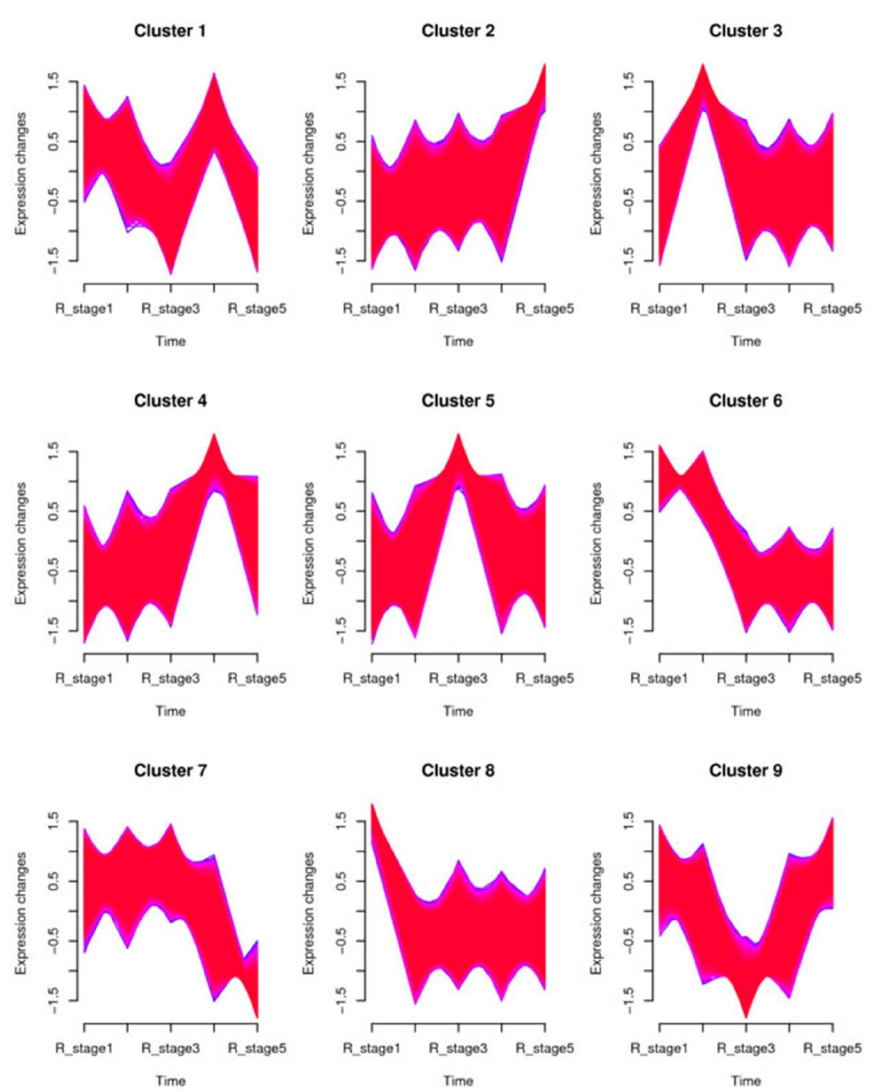
Figure 5. Temporal expression patterns of the di ff erentially expressed mRNAs in five development stages of the receptacle.